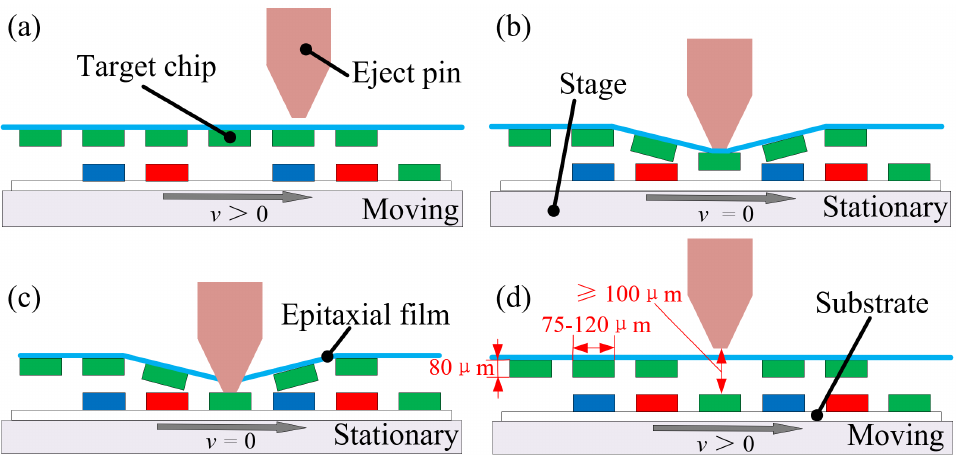
Figure 1. Conventional chip ejection transfer process with a mechanical ejector pin. ( a ) The target chip is moved below the ejector pin. ( b ) The ejector pin pushes the epitaxial film downward. ( c ) The target chip is contacted and fixed on the substrate. ( d ) The stage moves and the next chip is